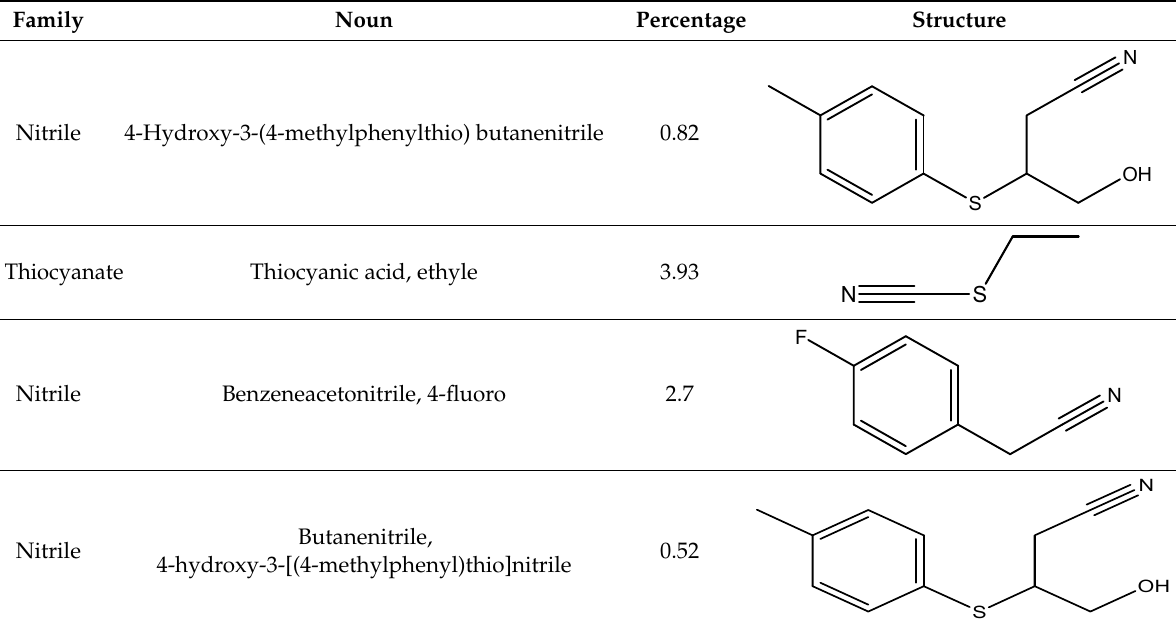
8 of 15 Table 6. Identified constituents classified by types of organic compounds and corresponding pro ‐ portions. Constituents (%)